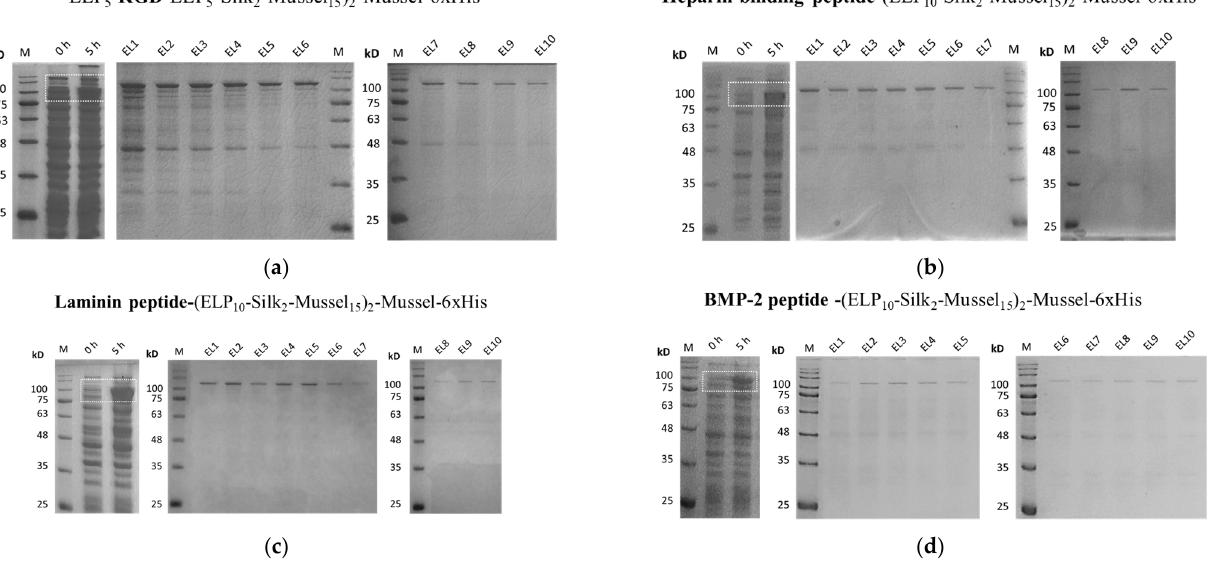
Figure 2. Electrophoresis in 10% w / v SDS-polyacrylamide gels of the fractions after overexpression (20 μ L of cell extract per lane) and purification (10 μ g of protein per lane) of the polypeptides from BL21 E. coli cells. ( a ) ELP 5 -RGD-ELP 5 -Silk 2 -Mussel 15 ) 2 -Mussel-6xHis, ( b ) Heparin-binding peptide-(ELP 10 -Silk 2 -Mussel 15 ) 2 -Mussel-6xHis, ( c ) Laminin peptide-(ELP 10 -Silk 2 -Mussel 15 ) 2 -Mussel- 6xHis, and ( d ) BMP-2 peptide -(ELP 10 -Silk 2 -Mussel 15 ) 2 -Mussel-6xHis. 0 h: before induction of overexpression, 5 h: 5 h after induction of overexpression with 1 mM IPTG, and EL1-EL10: elutions with 250 mM imidazole. M: protein